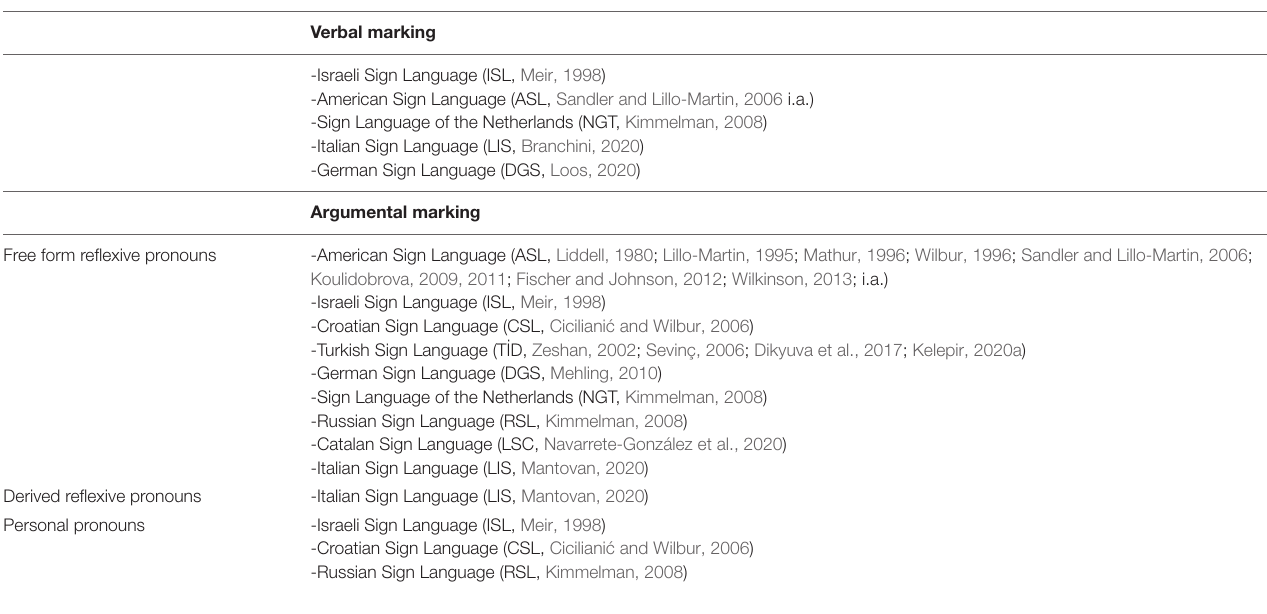
TABLE 1 | Reflexivization Strategies Attested in Sign Languages.